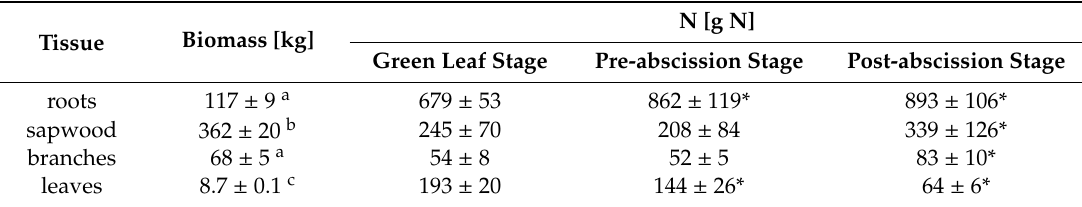
Table 5. Biomass during the green leaf stage and seasonal changes in whole-tree N content per plant tissue of Fagus crenata Blume ( n = 4) with ± denoting SD.